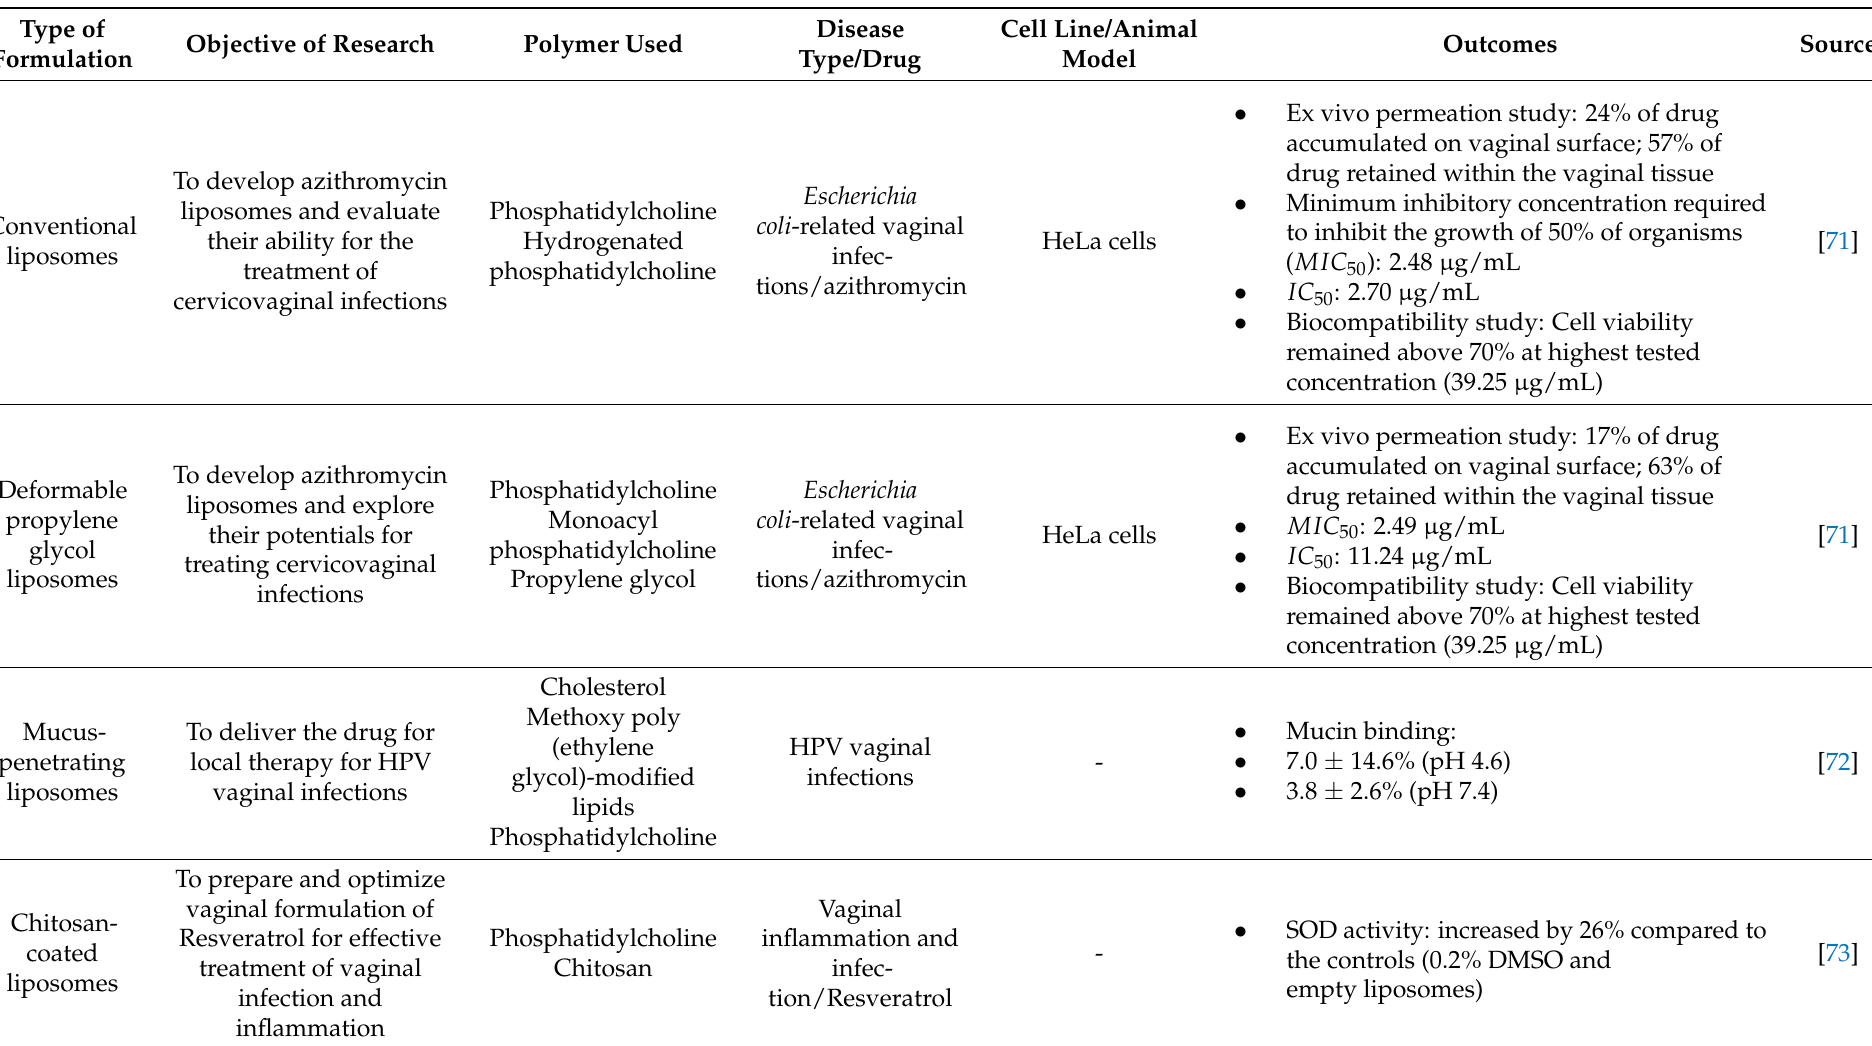
Table 2. Mucoadhesive polymeric approaches for vaginal drug